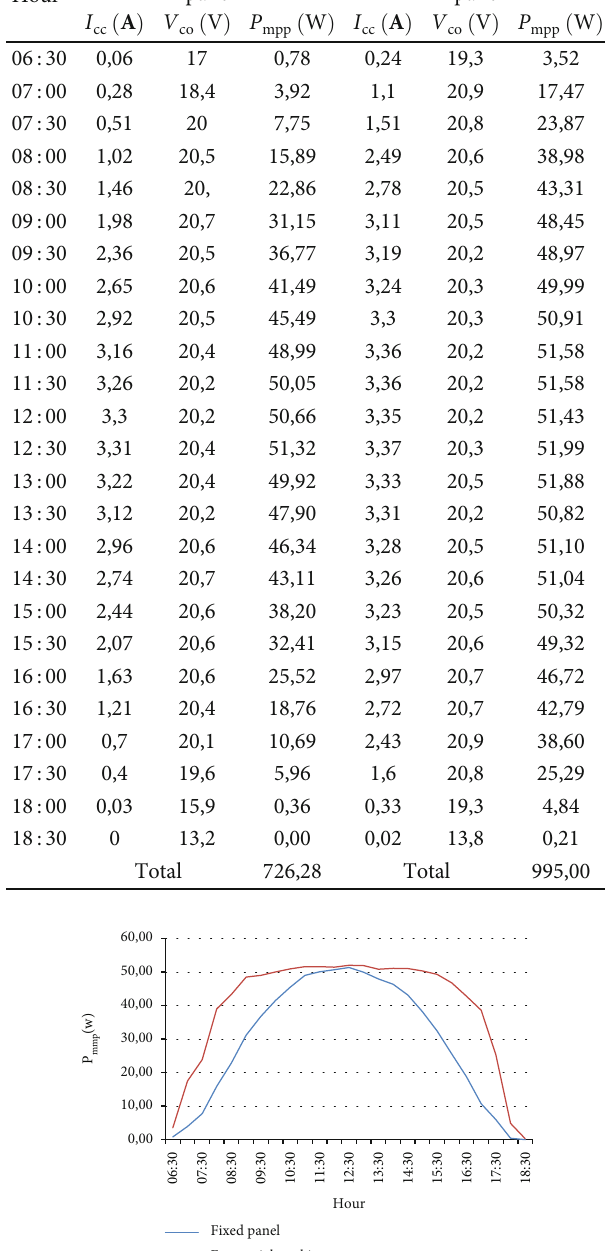
Table 5: The results of the experiment. The results of the fi xed The results of the moving panel Hour